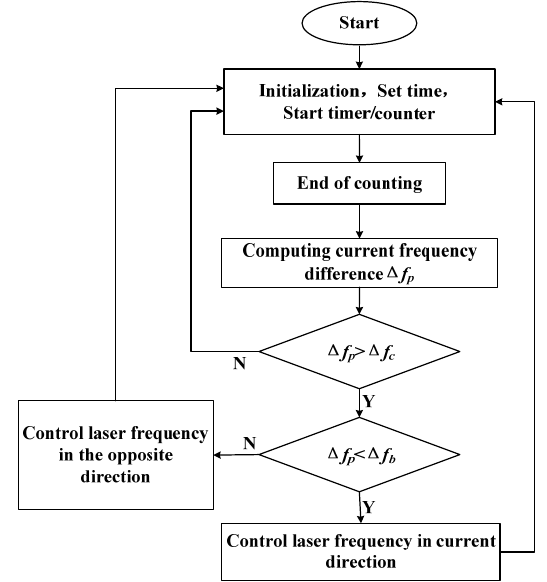
Figure 3. Flow chart of frequency discrimination and control program.